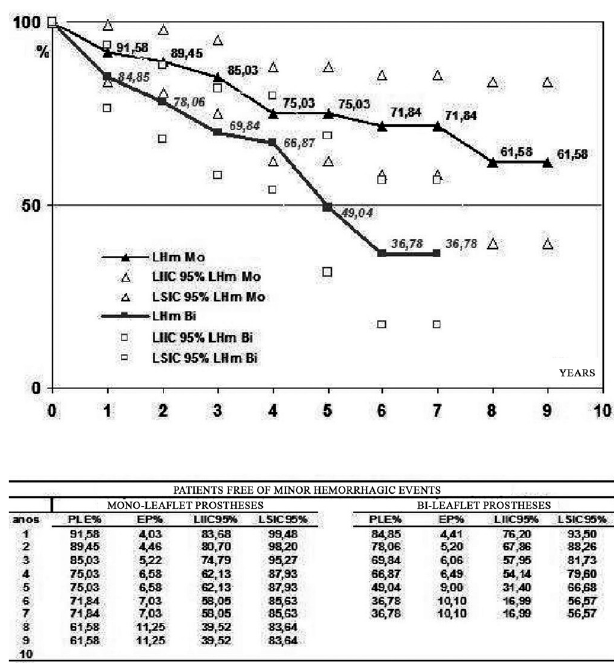
Fig. 8 - Curves and actuarial data showing the percentage of patients free from minor bleeding events mBE (ordinate) with time - years (abscissa) for both types of prostheses studied. Mo = Mono-leaflet prosthesis; Bi = Bi-leaflet prosthesis; SE = standard error range; LLCI95% = lower limit of 95% Confidence Interval and ULCI95 % = Upper Limit of 95% Confidence